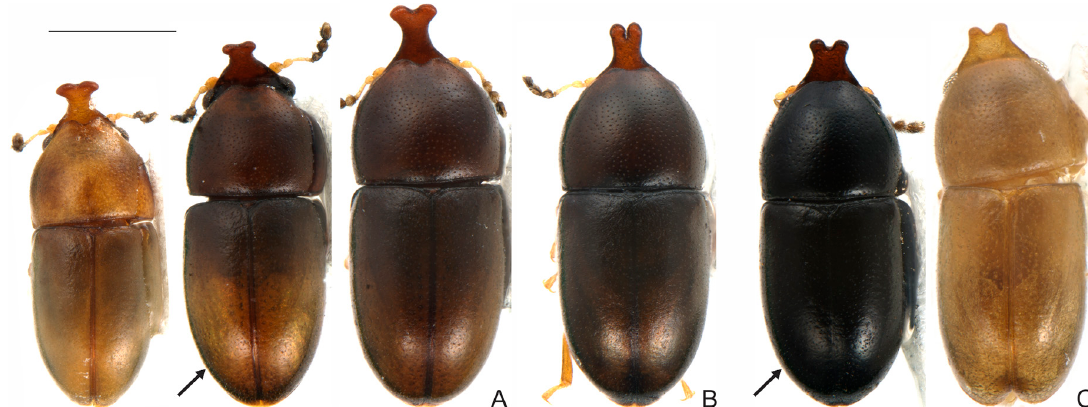
Figure 8. Colour variation in specimens of Ceracis furcifer Mellié . ( A ) Colour variation among individuals from a single locality (Paranhos, MS, Brazil), arrow showing specimen “half brown, half dark-brown”. ( B ) A specimen from Mambaí (GO, Brazil) showing an intermediate colour in comparison to specimens shown in A and C. ( C ) A teneral (right) and homogeneously black individual (left, black arrow) from Araguaína (TO, Brazil). Scale bar: 0.5 mm.